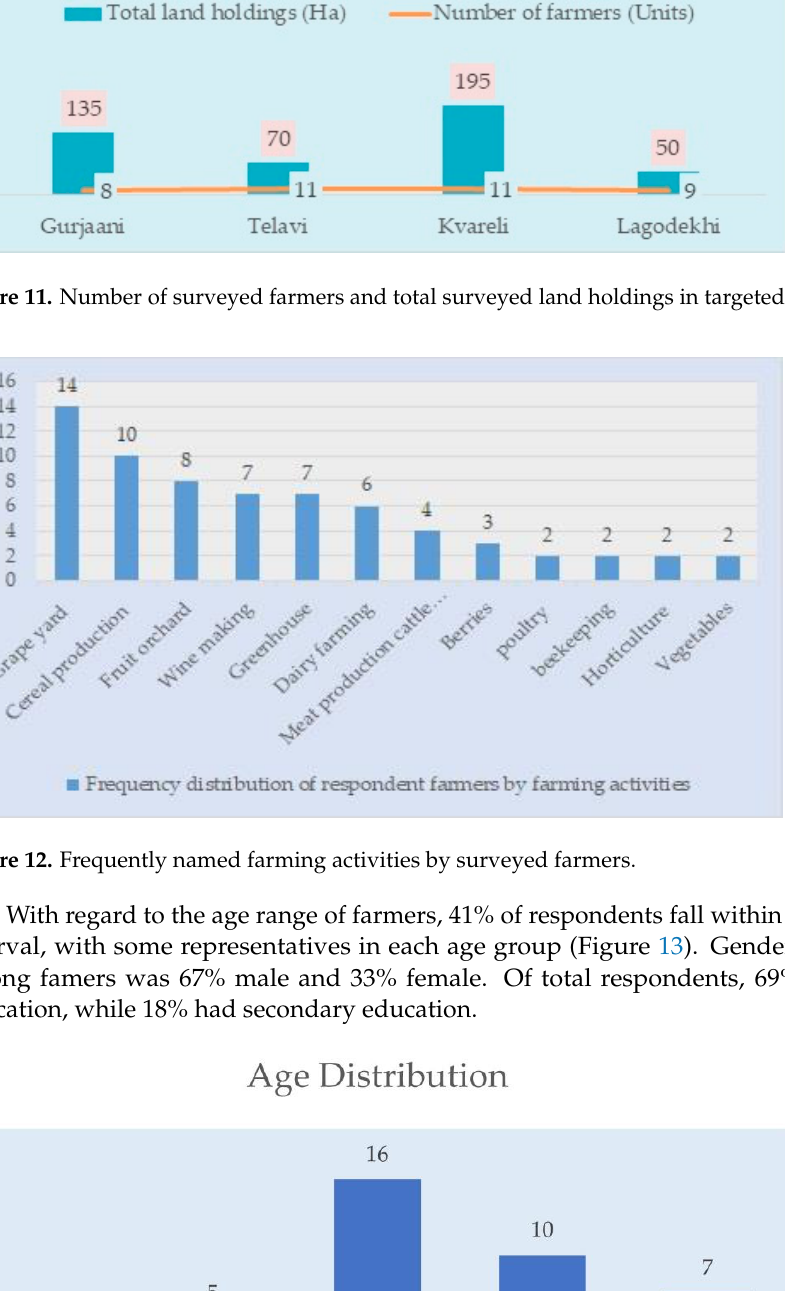
Figure 14. Distribution of sent amounts in the trust game. The results of the receivers in response to transfers are varying. Figure 15 shows that most people returned in the range of 40 – 60% of tokens received, but it is close to even distribution in other ranges too. Five of the receivers (13%) decided not to return anything, while another five (13%) returned 100% of the tripled amount they received. On average, 51% of the received tokens were returned to senders.